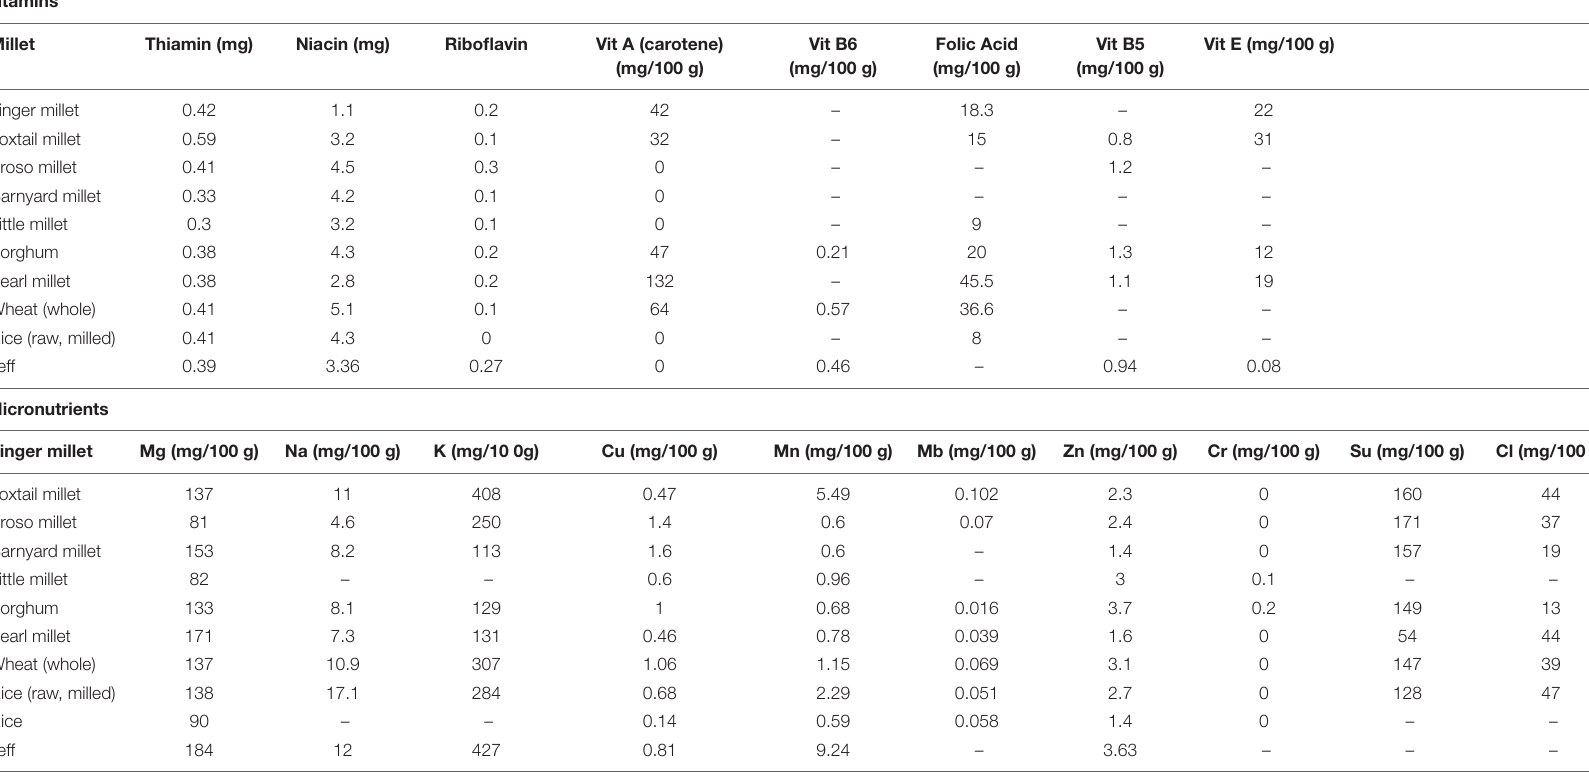
TABLE 2B | Nutritional profile of selected millets compared with those of wheat and rice.